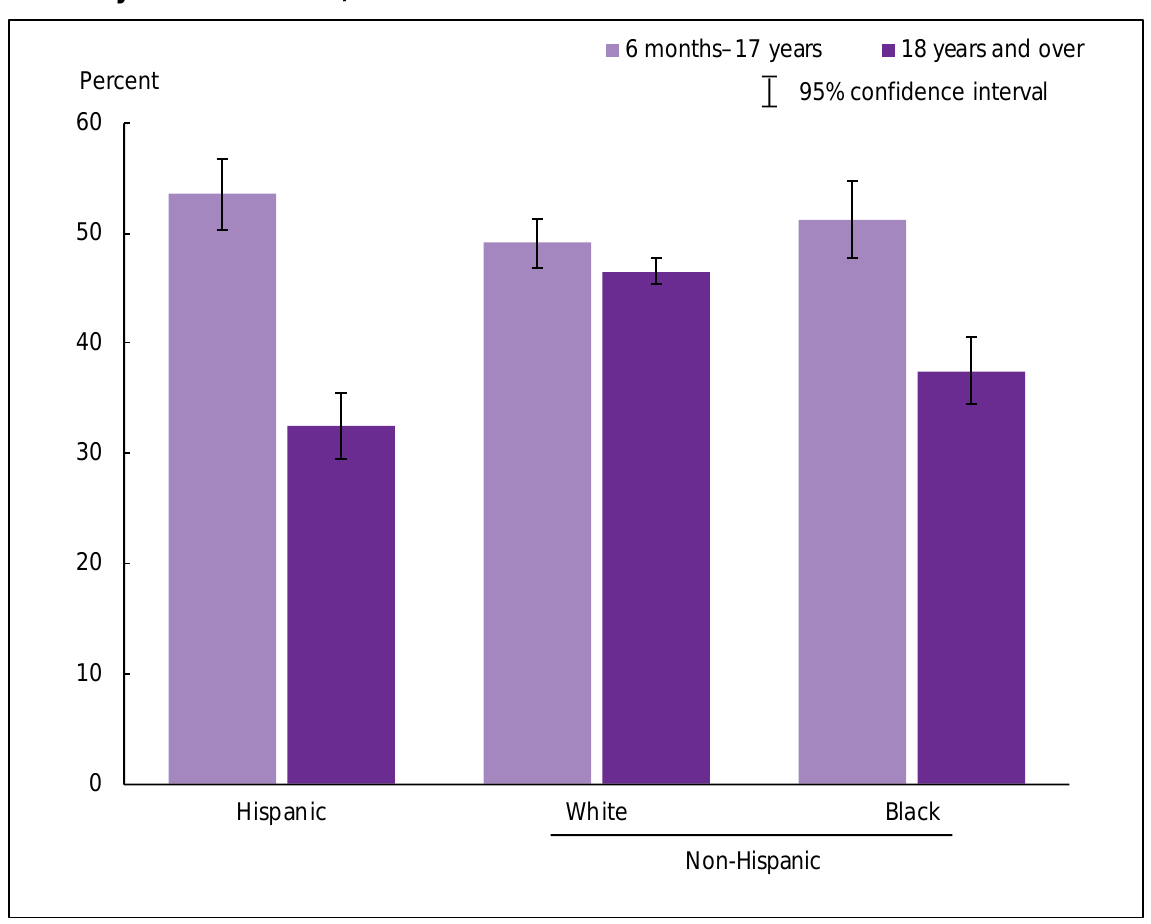
Figure 4.3. Percentage of persons aged 6 months and over who received an influenza vaccination during the past 12 months, by age group and race and ethnicity: United States,